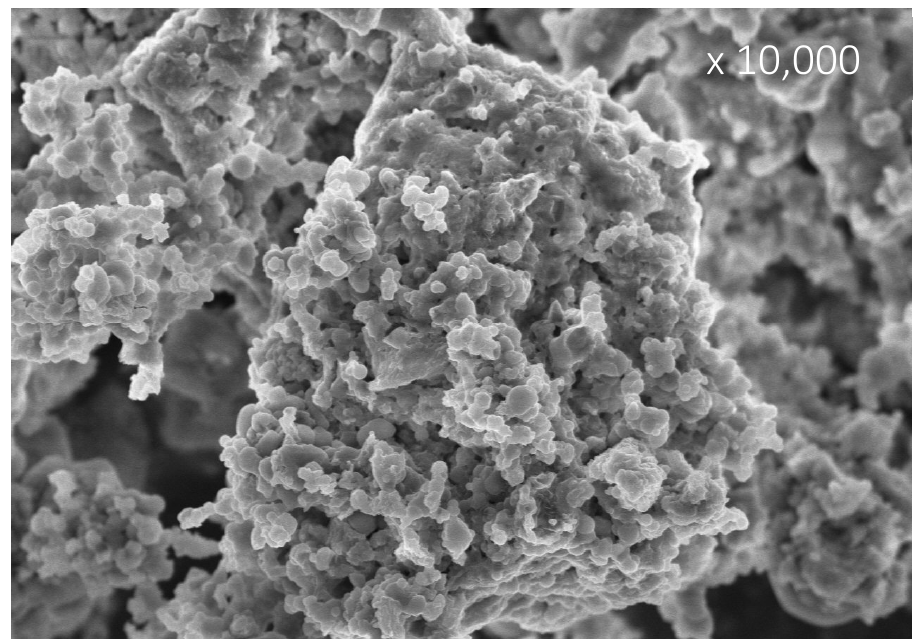
Figure 1. 1,000 and 10,000 times magnified images of calcium hydroxide.